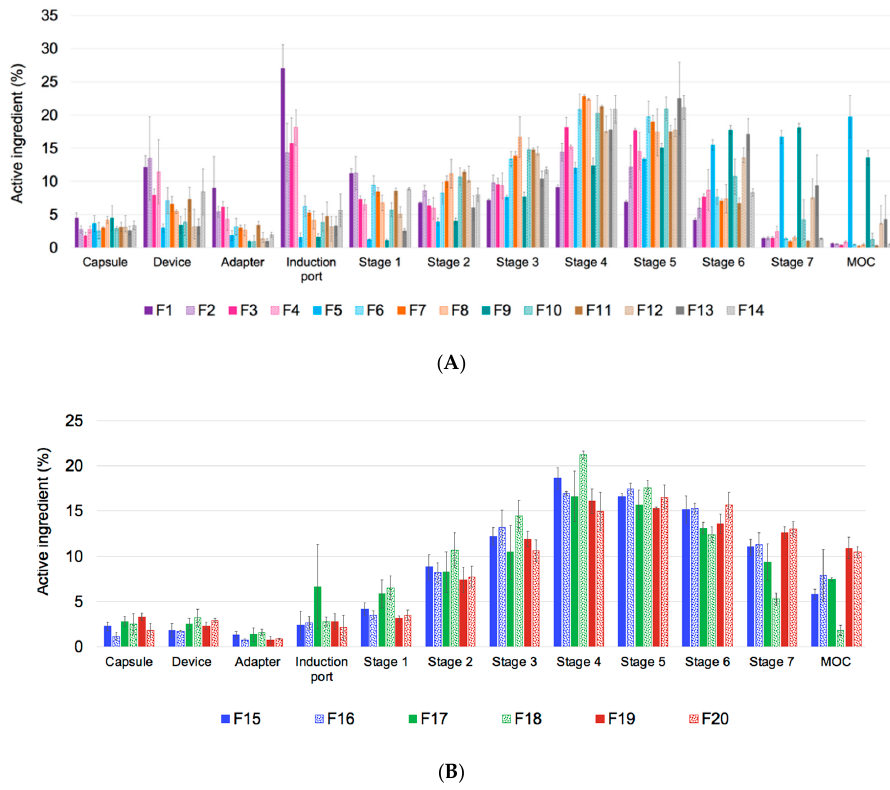
Figure 4. Aerodynamic diameter distribution of TFF remdesivir formulations when emitted from a Plastiape ® RS00 high-resistance DPI at a flow rate of 60 L / min ( n = 3); ( A ) formulations prepared in acetonitrile / water (50 / 50) co-solvent mixture; ( B ) formulations prepared in 1,4-dioxane / water (50 / 50) co-solvent mixture.